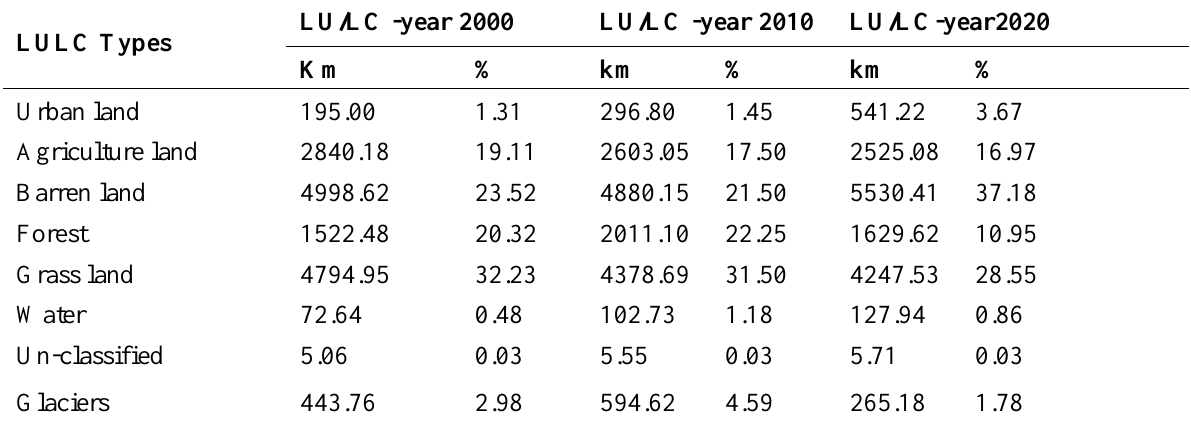
Table 4. The area coverage of LULC, percent, and rate between 2000, 2010, and